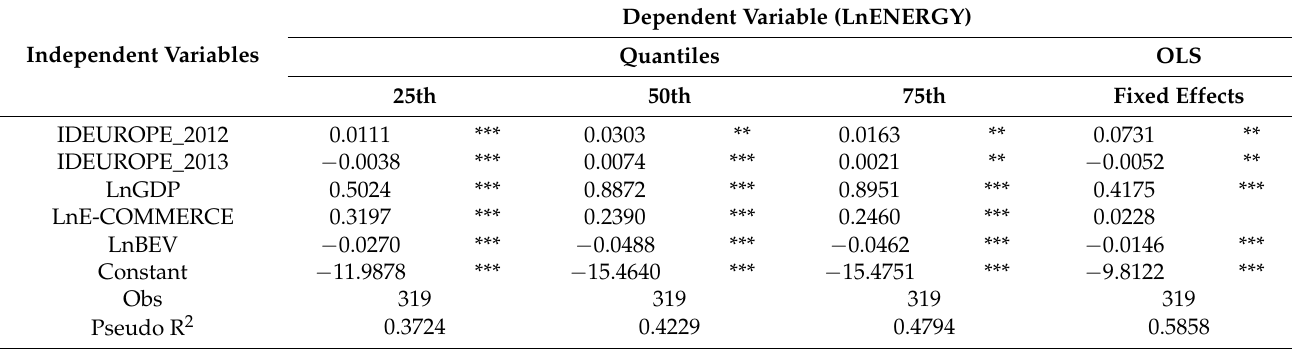
Table 11. Results from QRM and OLS with fixed effects with dummy